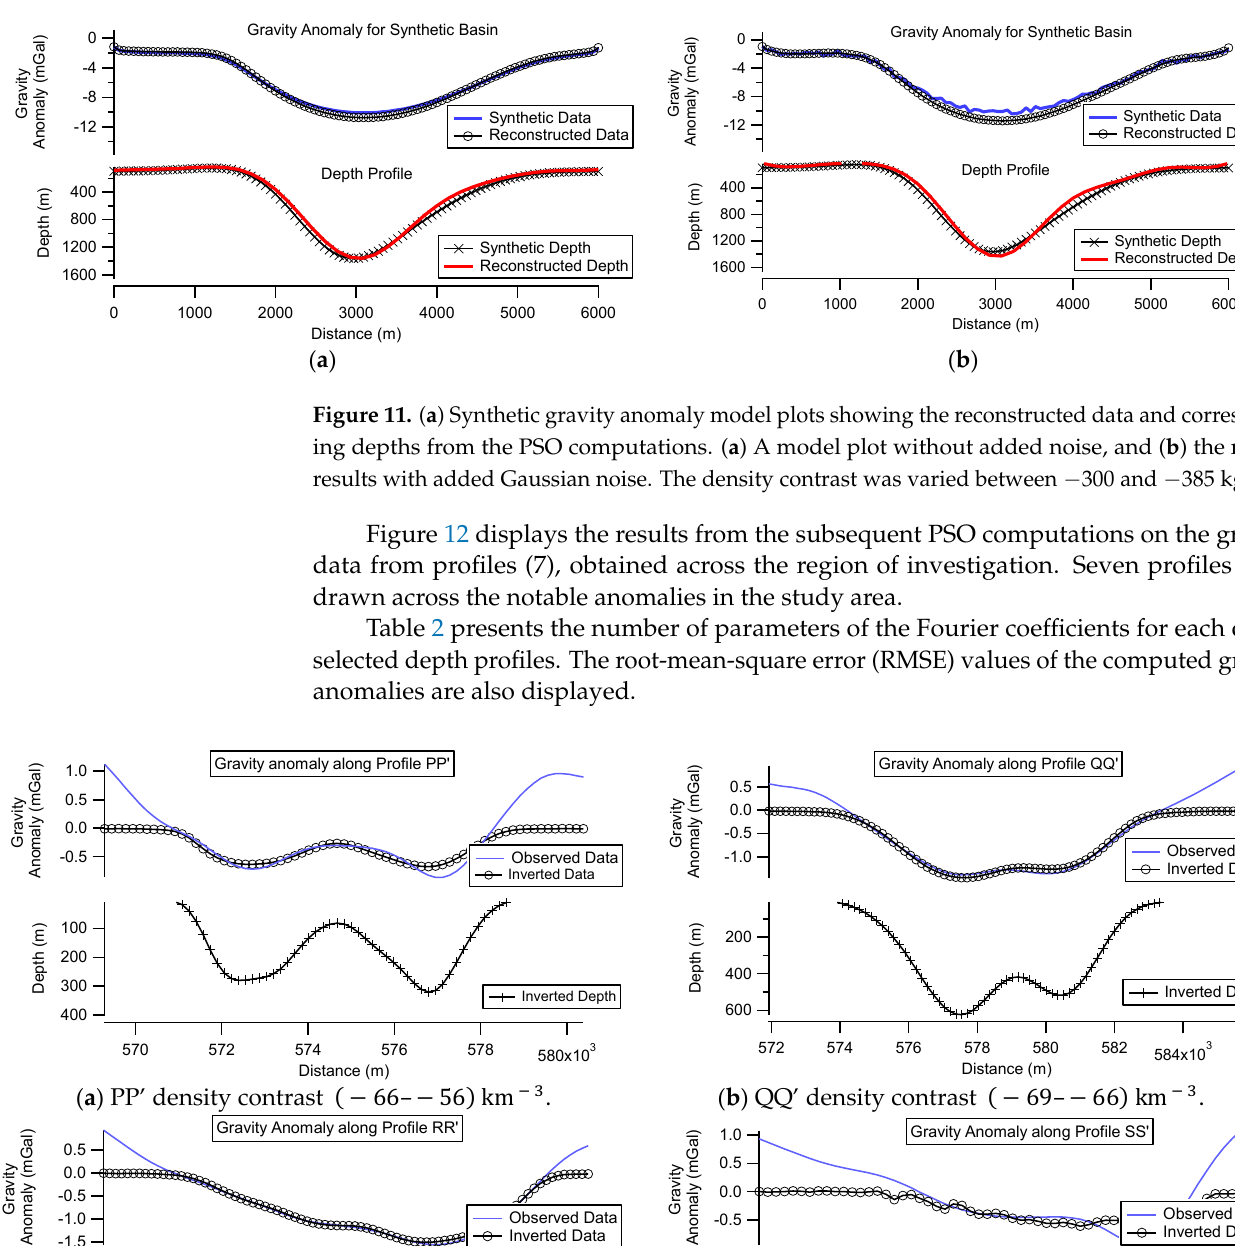
( b ) QQ’ density contrast (cid:4666) (cid:3398) 69– (cid:3398) 66(cid:4667) km (cid:2879) (cid:2871) .